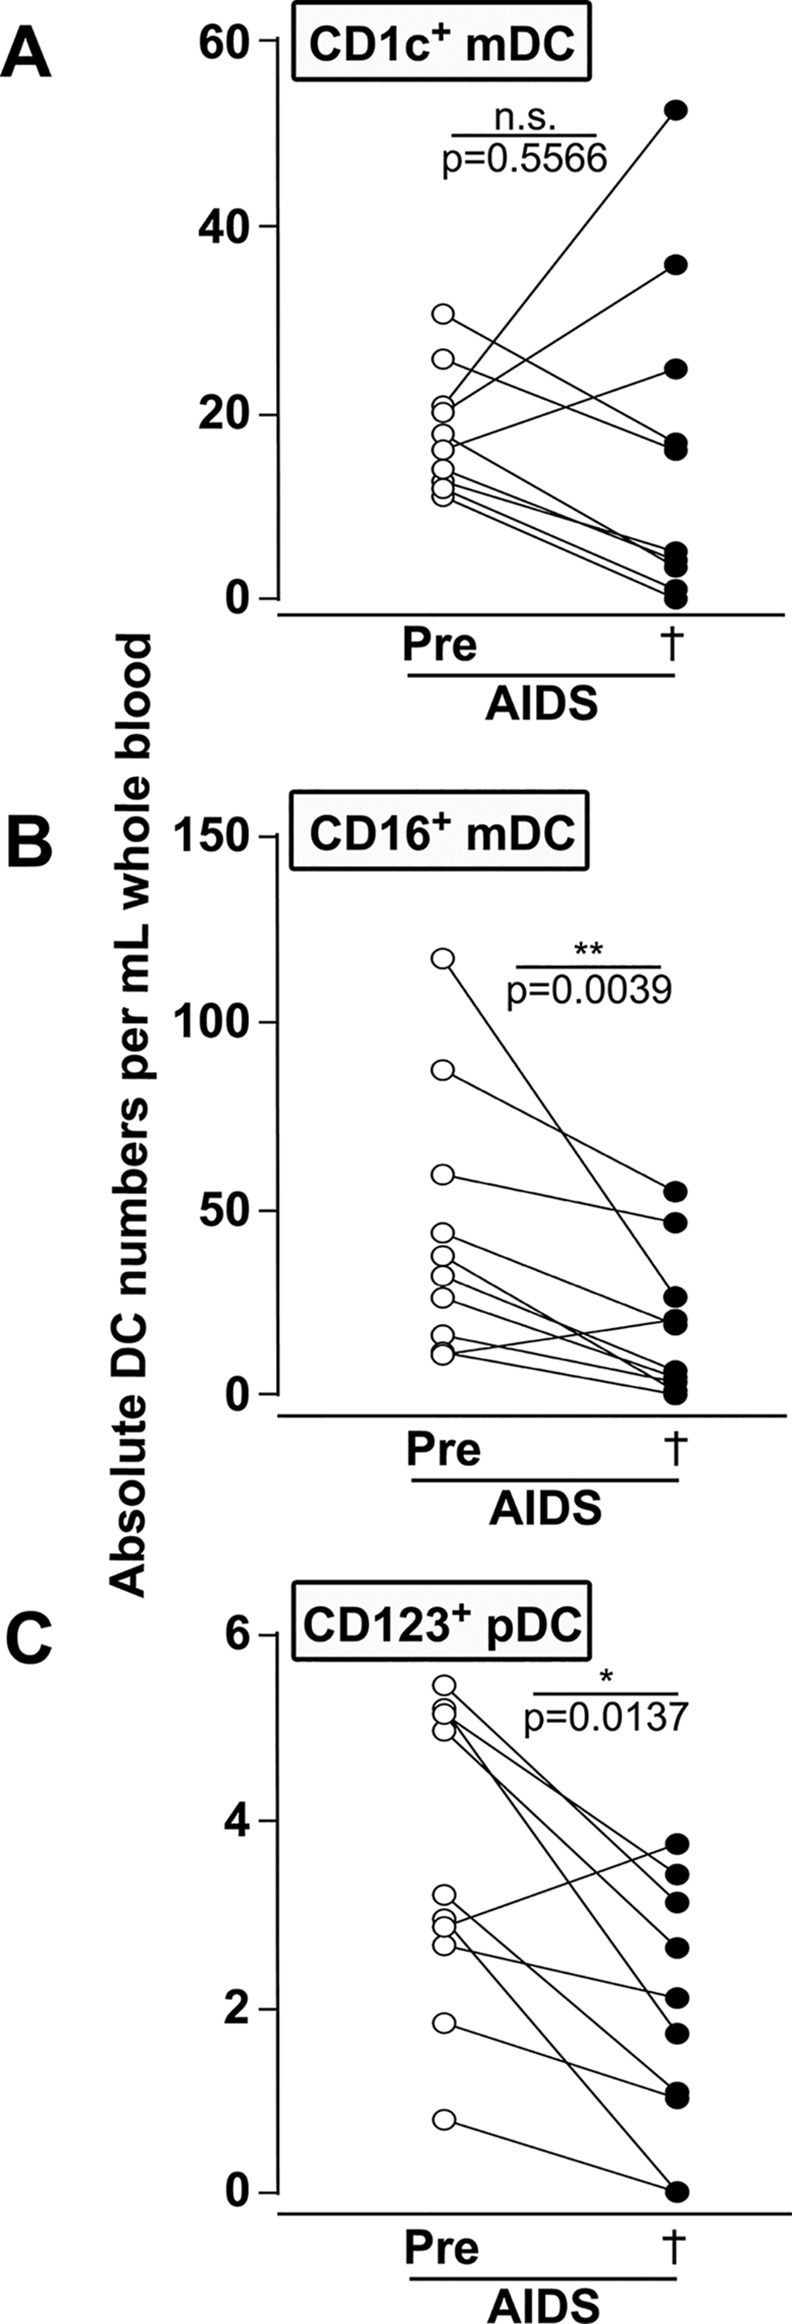
Unlike CD16+ mDCs and CD123+ pDCs, numbers of CD1c+ mDCs with AIDS are not significantly decreased compared to pre-infection.Absolute numbers of CD1c+ mDCs (A), CD16+ mDCs (B) and CD123+ pDCs (C) were measured before infection (Pre, white symbols) and at necropsy (†, black symbols) with AIDS are shown. The Wilcoxon rank sum test was used to perform pair-wise analysis for the absolute numbers of DC before infection and at necropsy with AIDS. P values and asterisks indicative of significant differences are shown; n.s., not significant.